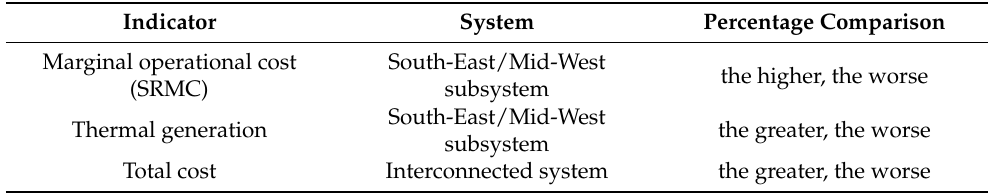
Table 4. Indicators selected for